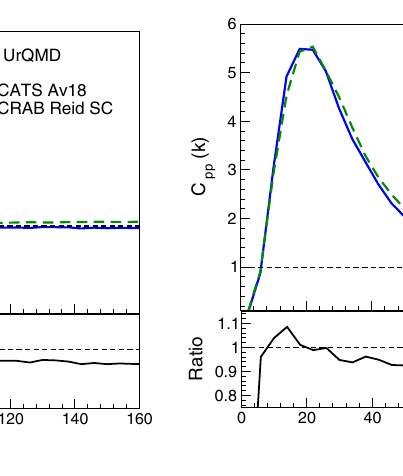
presented for CATS calculations with A v 18 and CRAB with a modified Reid SC potential (see 2.2 for details)